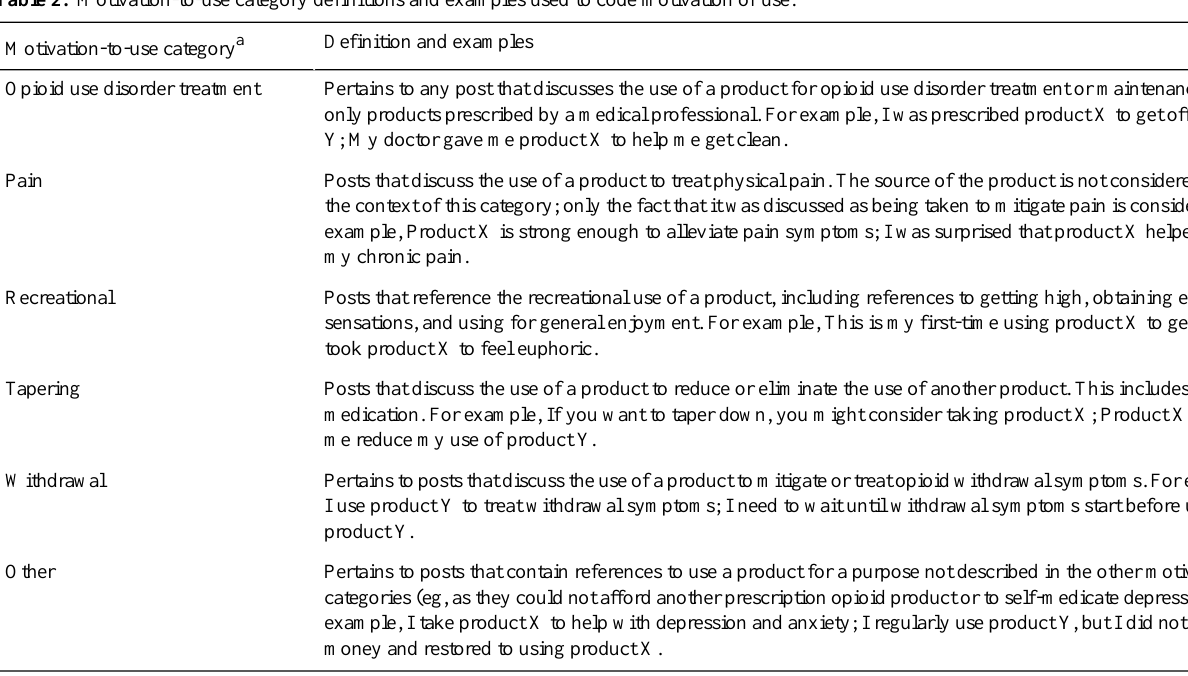
Table 2. Motivation-to-use category definitions and examples used to code motivation of